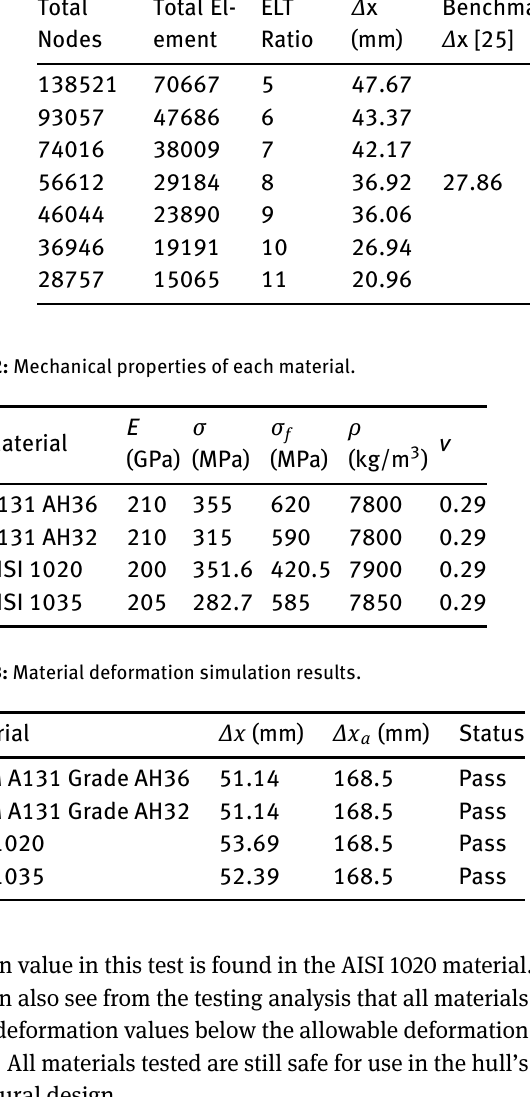
The applied load causes stress on the hull’s